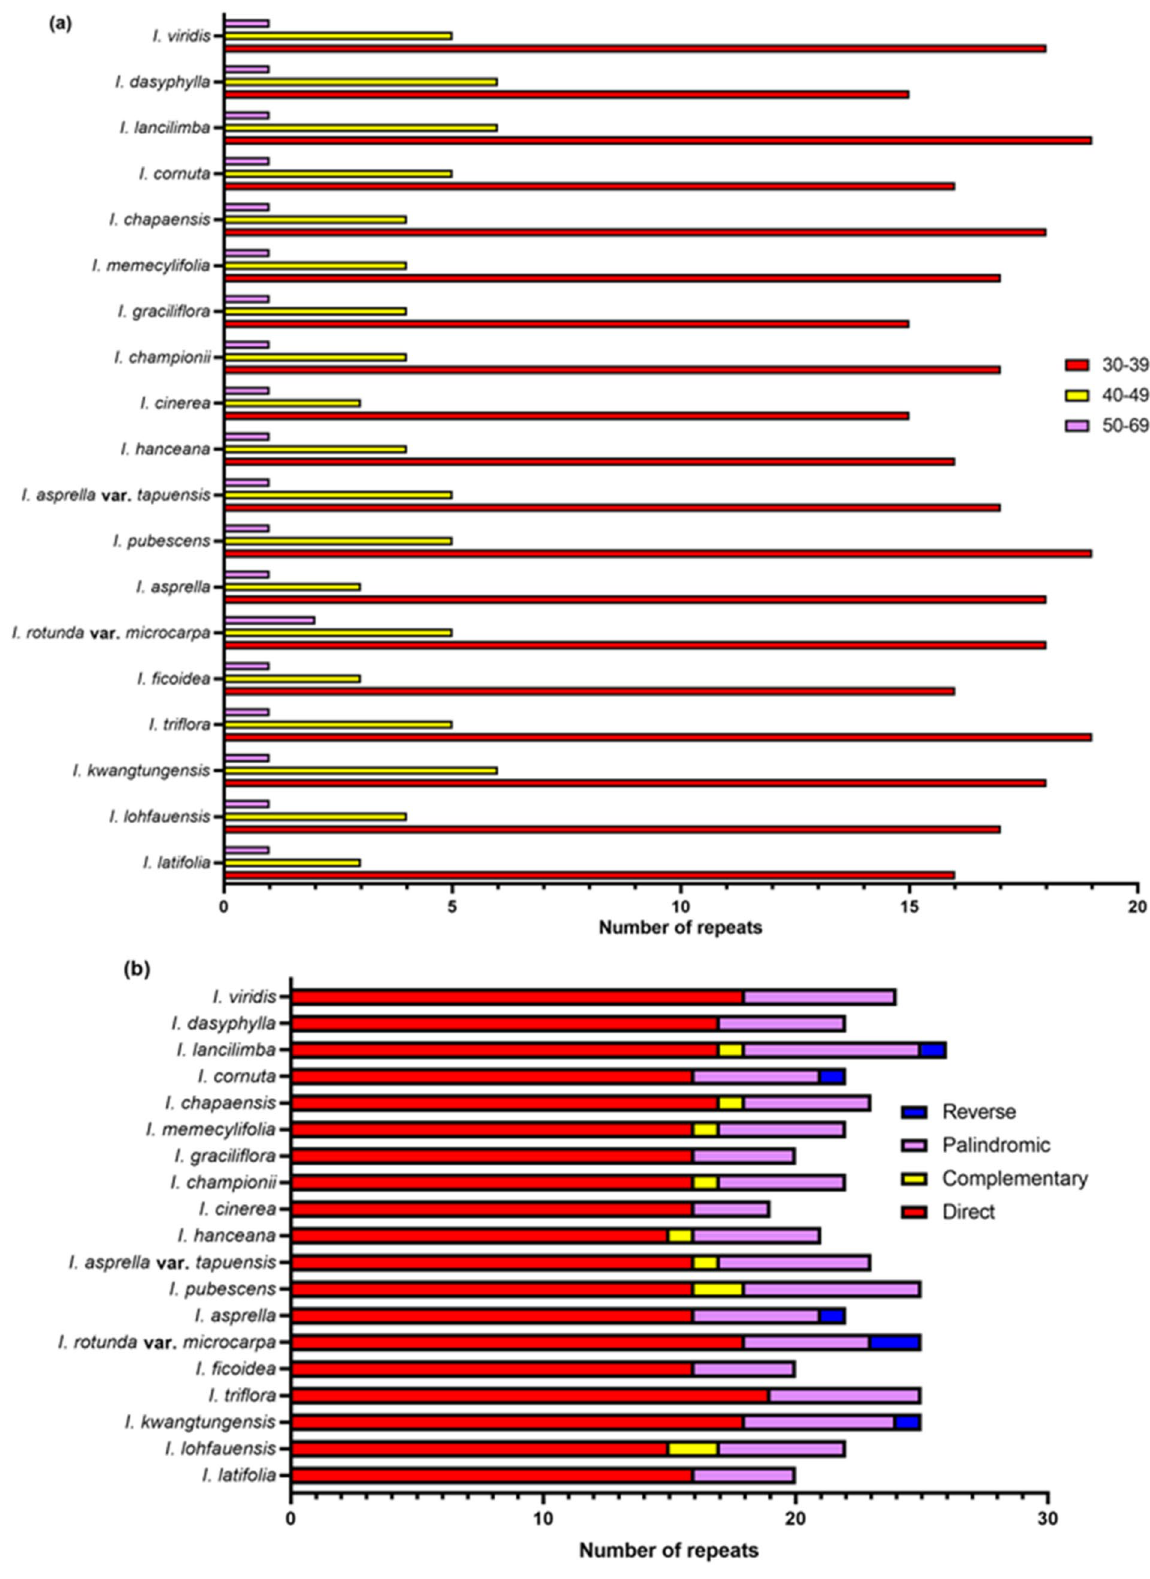
Figure 3. (a) Length of repeats and (b) frequency of repeating motifs of the 19 Ilex chloroplast genomes determined by